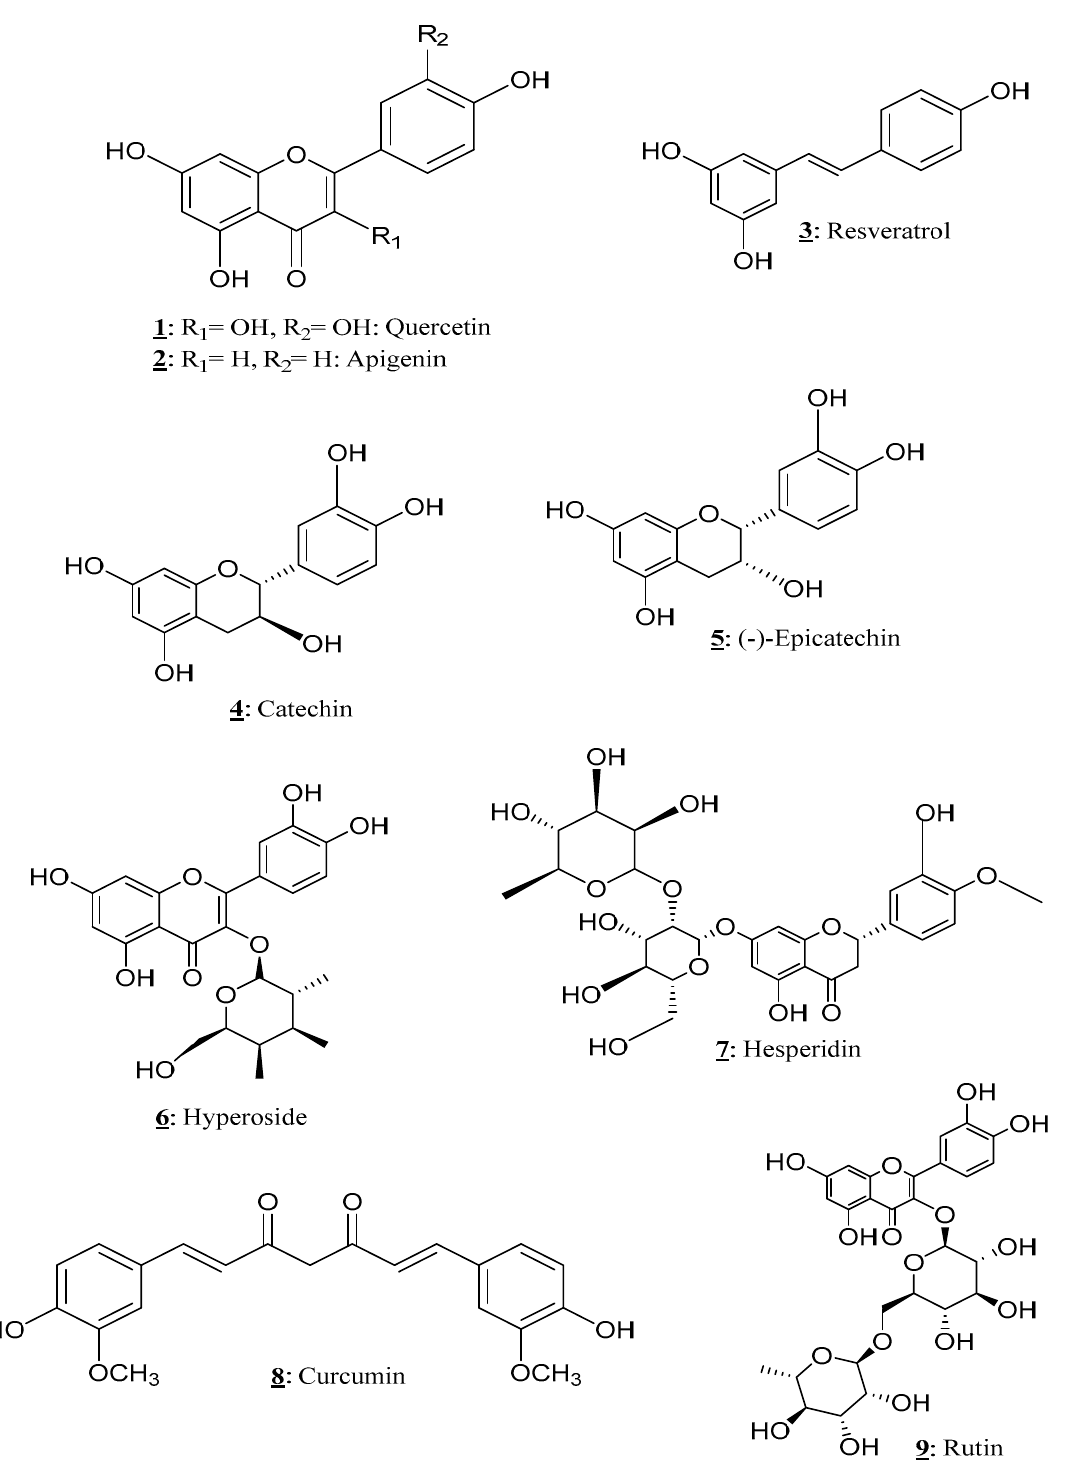
Figure 1. Structures of flavonoids and stilbenes with litholitic effects.